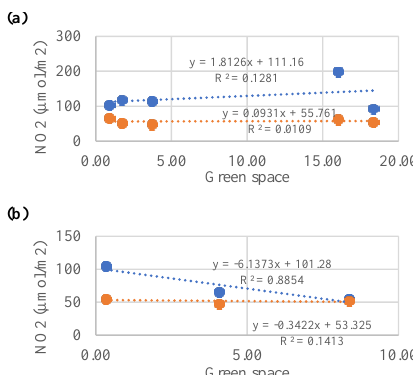
Figure 7. Influence of green space on NO 2